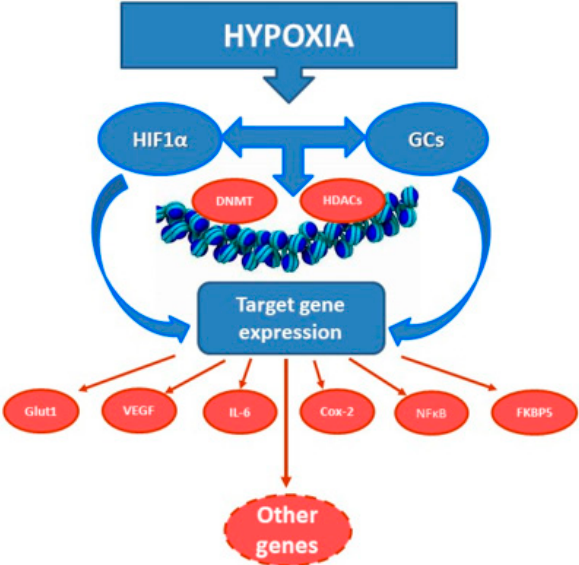
Figure 2. Hypoxia-induced increase of GC and HIF-1 α levels facilitates their intracellular cross-talk involving related downstream mechanisms or directly leads to activation of a number of their target genes. It might also reprogram expression of other genes via modulation of the activity of DNA methyltransferases and histone deacetylases, leading to modification of chromatin structure and accessibility of gene promoters to various transcription or regulatory factors.